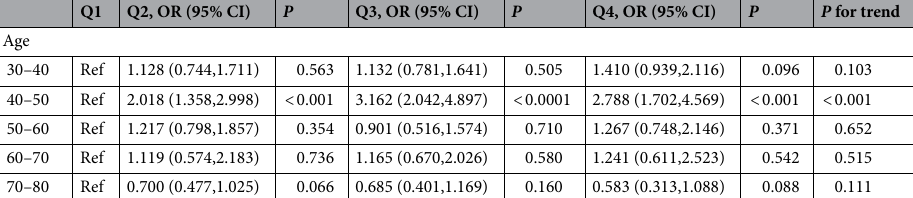
Table 2. Stratified analyses of the relationship between VAI and the presence of periodontitis according to age. VAI visceral adiposity